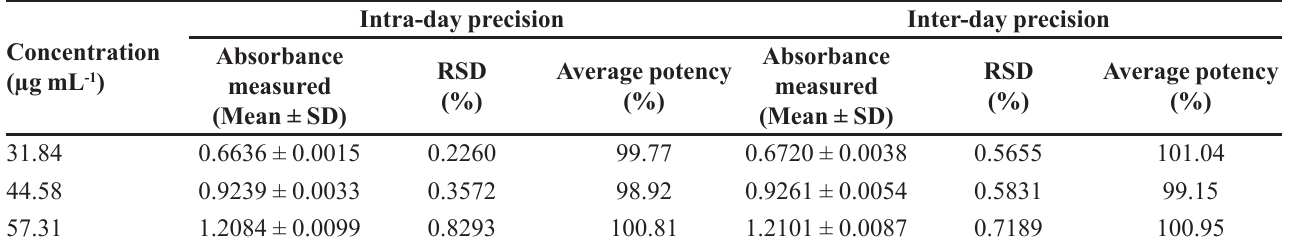
TABLE I - Intra-day and inter-day precision determined for three different concentrations of MTD ( n = 3)